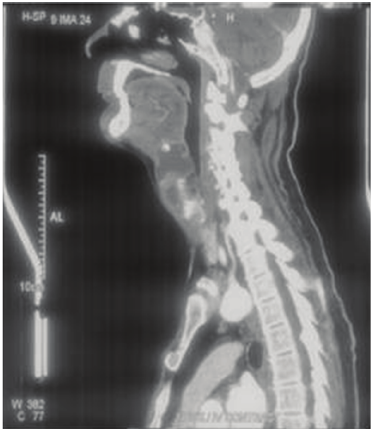
Figure 3: Involvement of the preepiglottic